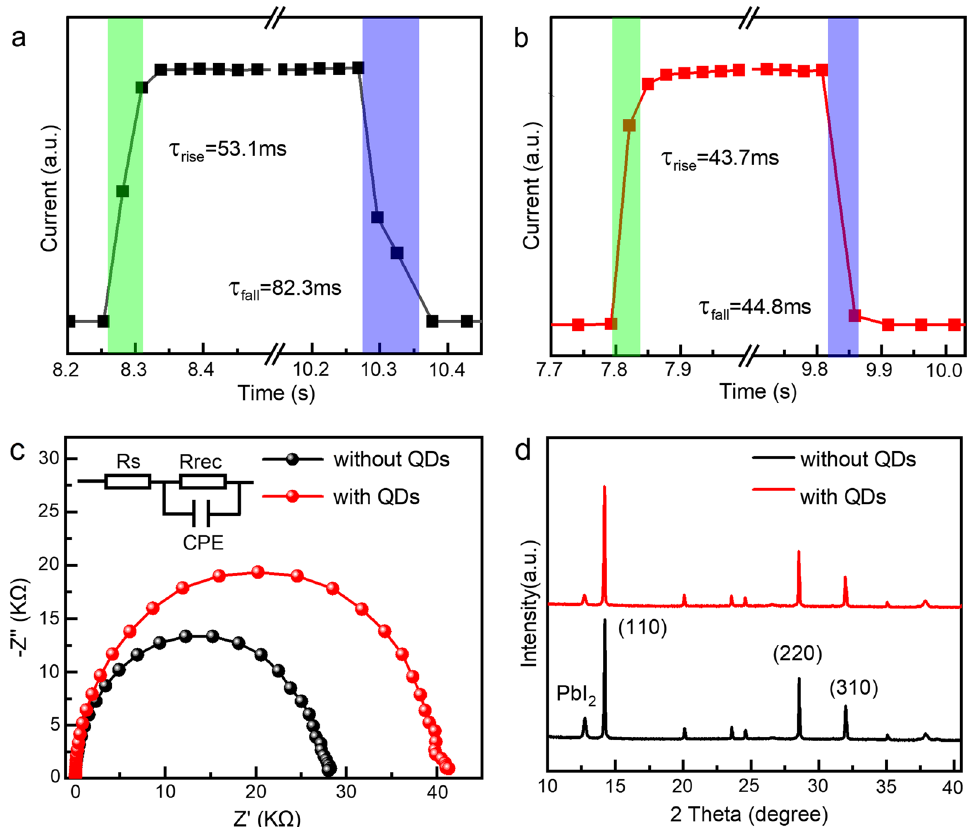
Fig. 8 a-b Response time diagram of the control device and after passivated by the QDs interface. c Nyquist diagram. d XRD pattern of the perovskite film one week